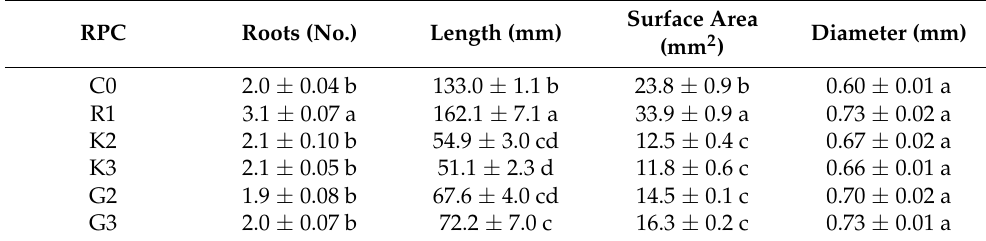
In columns, different letters indicate significant differences within parameters (S.N.K. test, p ≤ 0.05; mean ± SD, n = 3) C0: untreated control; R1: Rhizopon AA (1% IBA); K: Kelpak ® ; G: Goteo ® ; K2: 2 mL L − 1 ; K3: 3 mL L − 1 ;